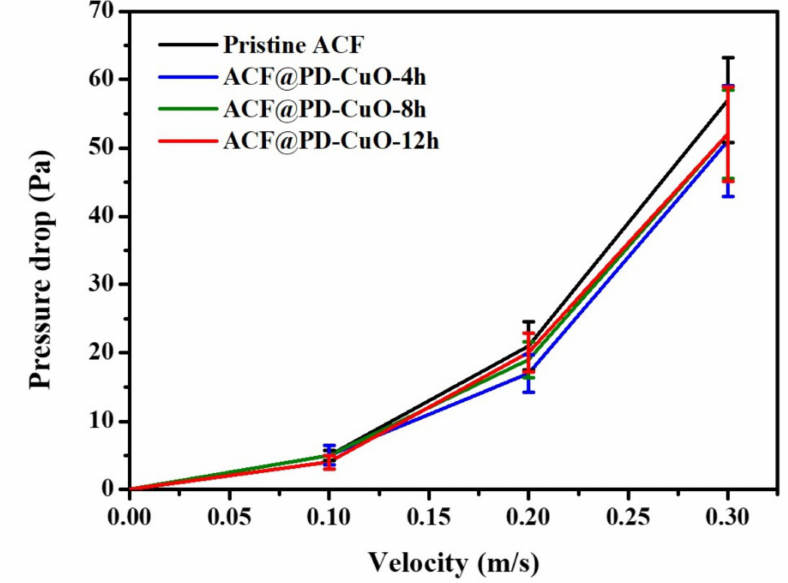
Figure 7. Pressure drop of pristine activated carbon fibers (ACF) and ACF@polydopamine-cupric oxide (PD-CuO) filters as a function of air velocity with di ff erent coating times (4, 8, and 12 h).